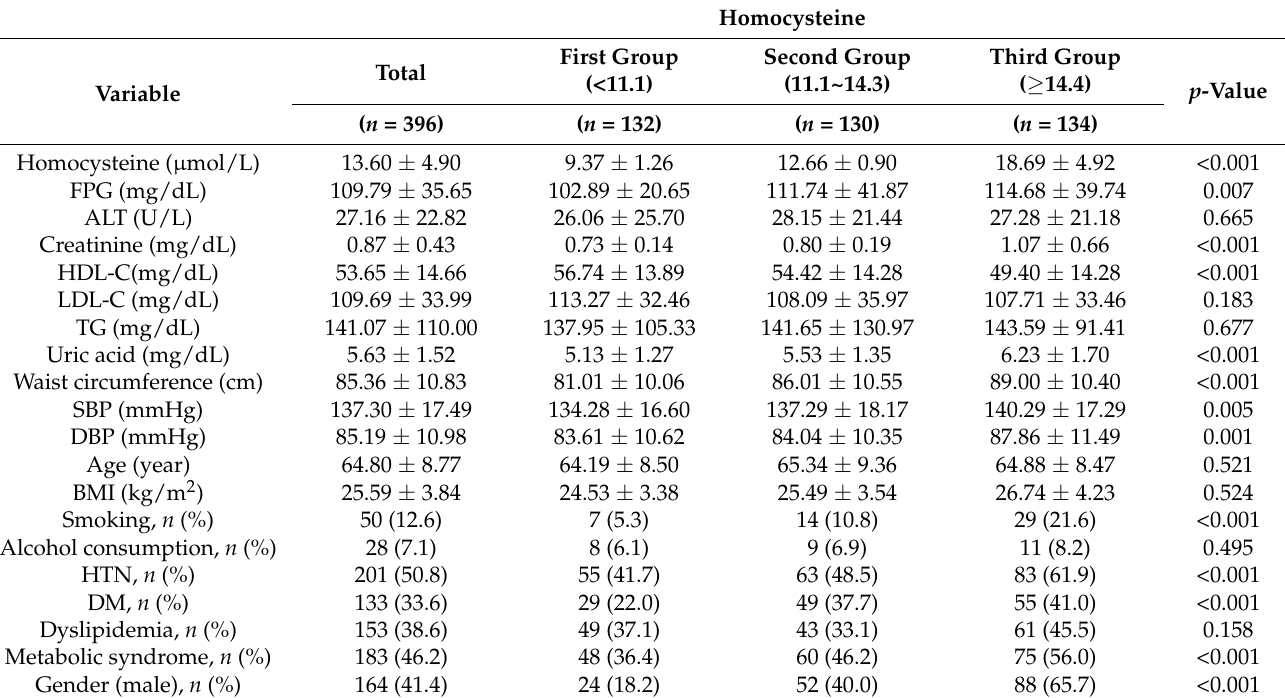
Table 3. The characteristics of study subjects according to tertiles of